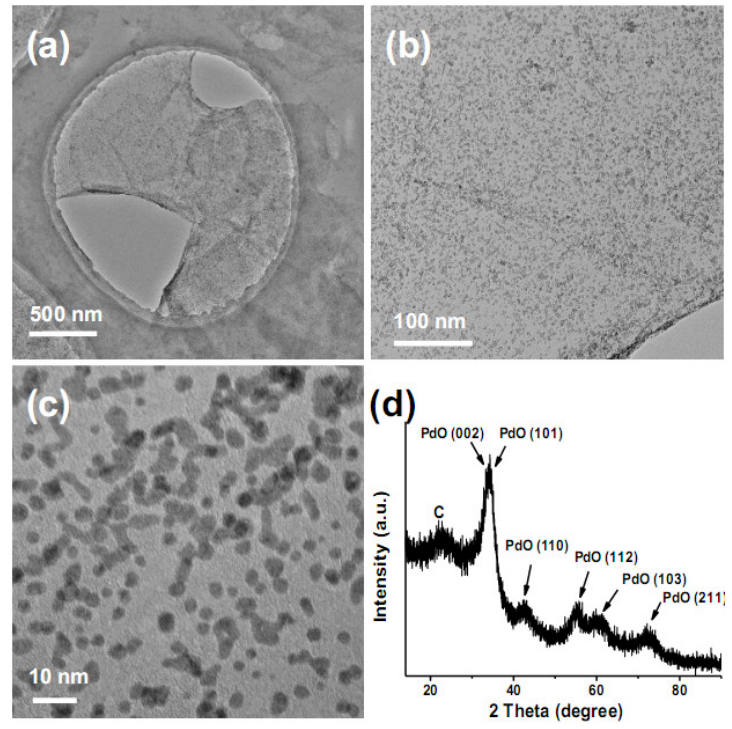
Figure 9. TEM images (a-c) and XRD pattern (d) of